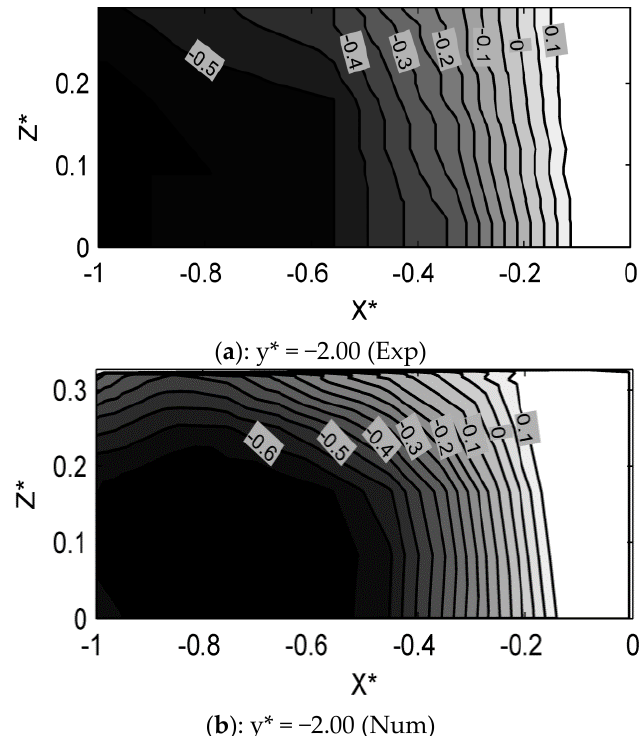
Figure 6. Verification graphs between the outcomes of the CFX model and the Ramamurthy and his colleagues’ experimental model in y* = − 2.00.